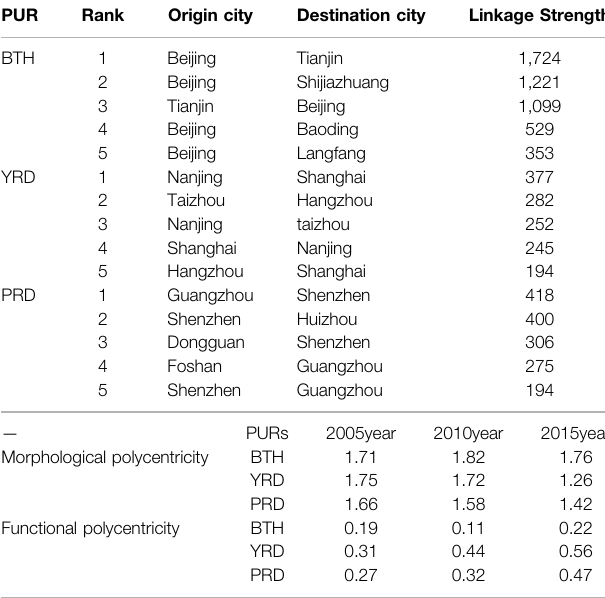
TABLE 1 | Top fi ve innovation linkages of Chinese three PURs in 2015. Morphological polycentricity and functional polycentricity of three PURs. PUR Rank Origin